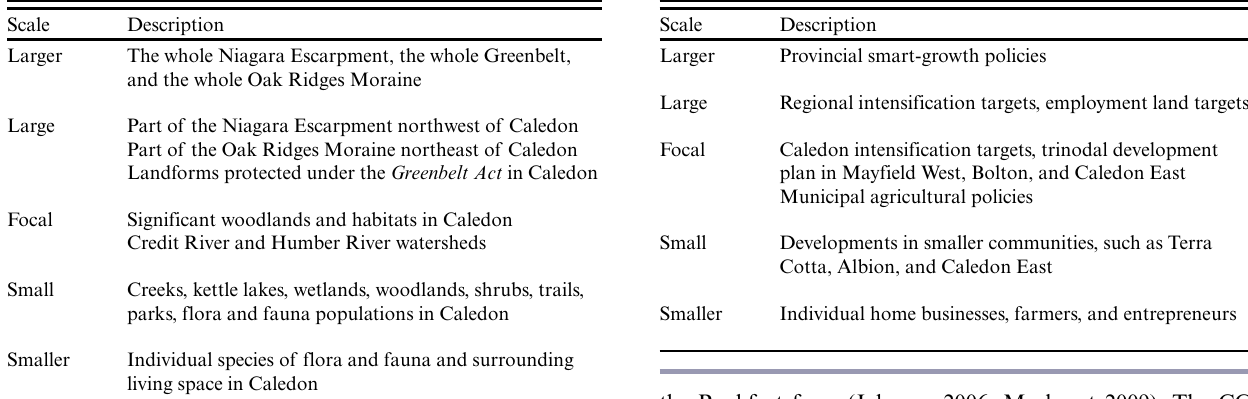
Table 5. Scales in the economic domain of Caledon in the